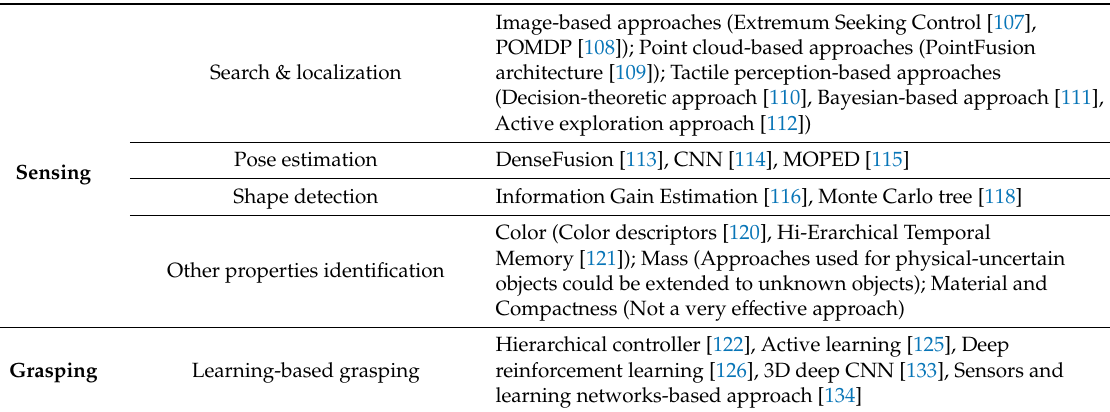
Table 3. Feature sensing and robotic grasping for unknown